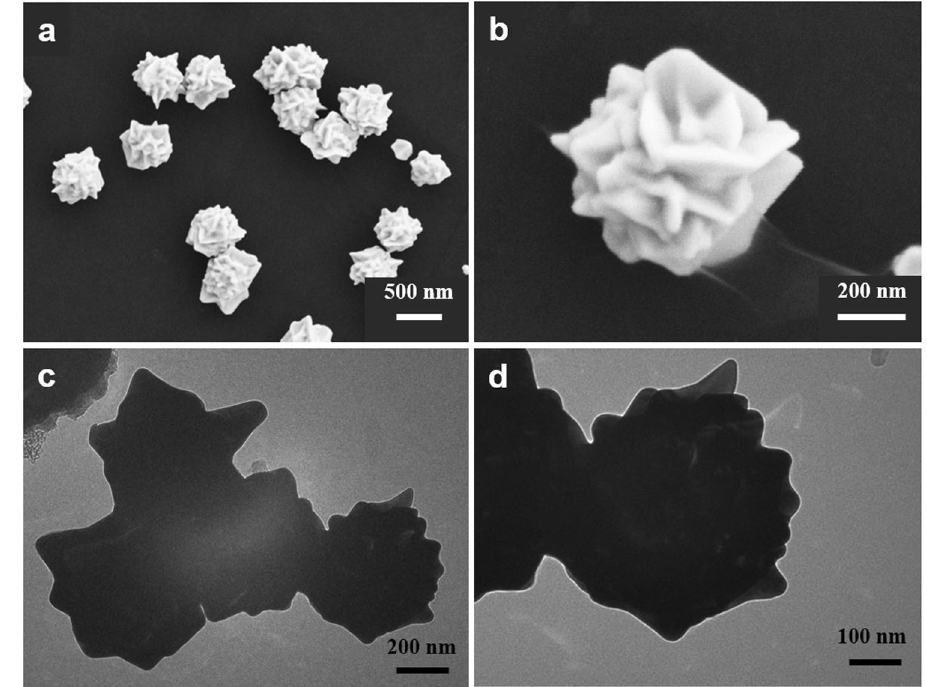
Figure 2. ( a ) Low-magnification and ( b ) high-magnification FESEM images, ( c ) low-magnification and ( d ) high-magnification TEM images of the prepared AuPt